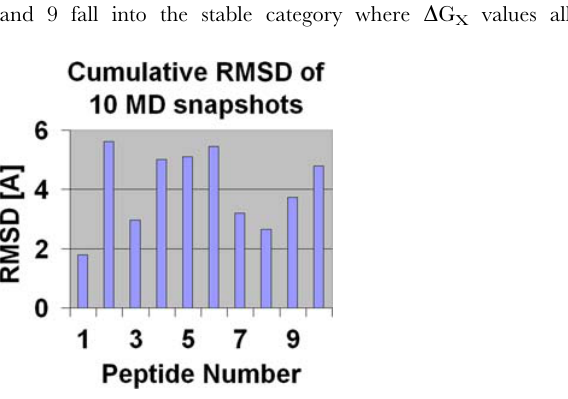
Figure 5. Cumulative root-mean-squared-deviation (RMSD) of optimal structural alignments of proteinlike motifs represent- ed in linear peptides. Identification of 4 consecutive amino acid stretches yielding the minimum cumulative pairwise root-mean- squared-deviation (RMSD) for snapshots included in the 10 nanosecond period forms the basis of optimal structural alignment for individual peptides. Lower values indicate more stable peptides with less structural